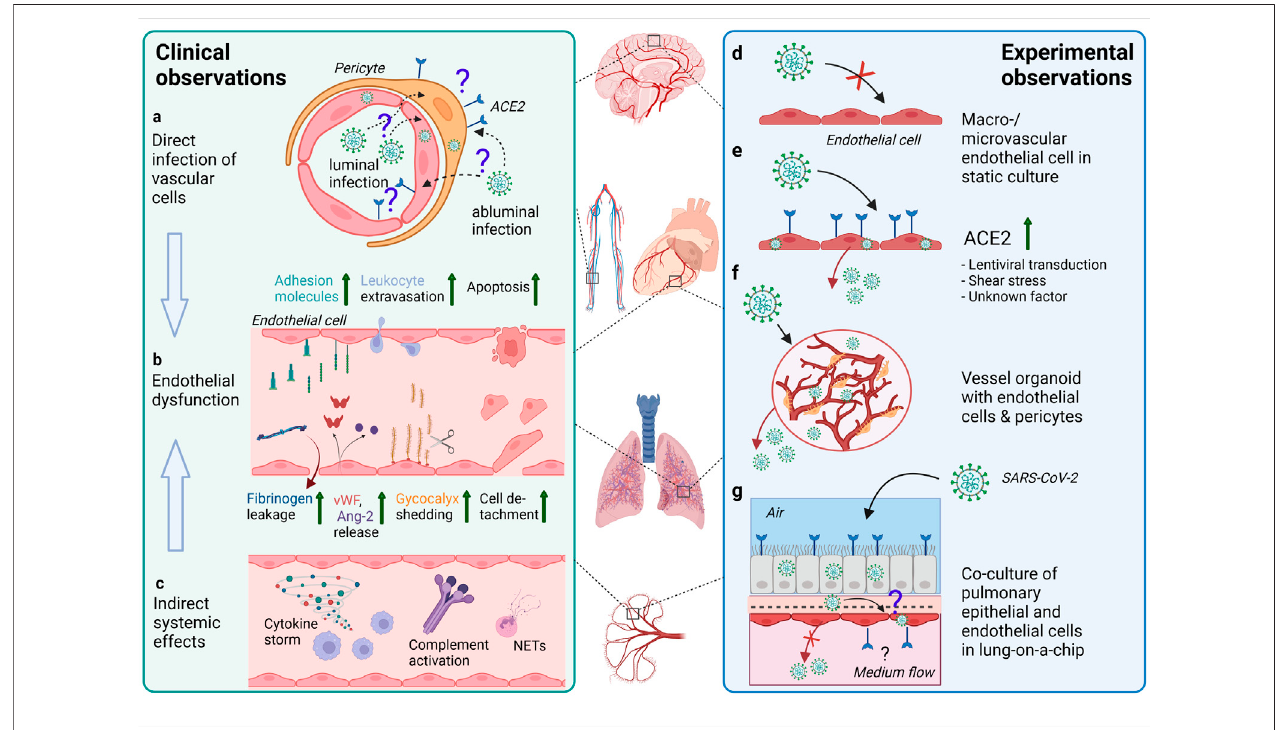
FIGURE3| EffectsofSARS-CoV-2infectionontheendotheliumasobservedinpatientsanddifferentexperimentalmodels. (A) Inendothelialcellsinvariousorgans (such as depicted in the middle of the fi gure) from COVID-19 patients, SARS-CoV-2 RNA or protein has been inconsistently detected. The ACE2 expression is rather found in pericytes than endothelial cells. Infection of vascular cells can happen from the abluminal side at primary sites of infection in the respiratory tract or from the luminal side in case of hematogenous SARS-CoV-2 dissemination to distal organs. To what extent infection of endothelial cells and/or pericytes occurs and contributes to COVID-19 pathology is unclear. (B) Endothelial dysfunction is not only observed in the pulmonary vasculature, but throughout the body as a hallmark of severe COVID-19 and may be one of the main contributors to increased frequency of thrombotic events. Elevated levels of markers of endothelial activation and injury including von Willebrand factor (vWF), angiopoietin-2 (Ang-2), soluble forms of several cell adhesion molecules and glycocalyx degradation products, and increased numbers of detached endothelial cells are found in COVID-19 patients ’ blood. Postmortem analysis of multiple organs has revealed perivascular immune cell in fi ltrates, decreased endothelial barrier properties as visualized by fi brinogen leakage and endothelial apoptosis in some of the COVID-19 patients. (C) Besides direct infection of vascularcells, immune-mediated mechanisms suchasexcessivepro-in fl ammatorycytokine production or complement-hyperactivationcanplay amajorrolein causing endothelial dysfunction. (D) Macro- and microvascular endothelial cells isolated from different anatomical locations (such as depicted in the middle of the fi gure) in conventional monolayer culture were not permissive to infection by SARS-CoV-2. (E) When ACE2 was introduced into endothelial cells by lentiviral transduction productive infection occurred. ACE2 expression inendothelialcellsmight also beinduced byshear stressor certain interferons. (F) In co-culture modelssuch ashiPSC- derivedvesselorganoidsconsistingofendothelialcellsandpericytes,productiveinfectionoccurred, (G) whereasinlung-on-a-chip-modelsinfectionofthelungepithelial compartment can lead to infection and cytopathogenic effects of the adjacent endothelial cells (This fi gure was made with biorender.com).